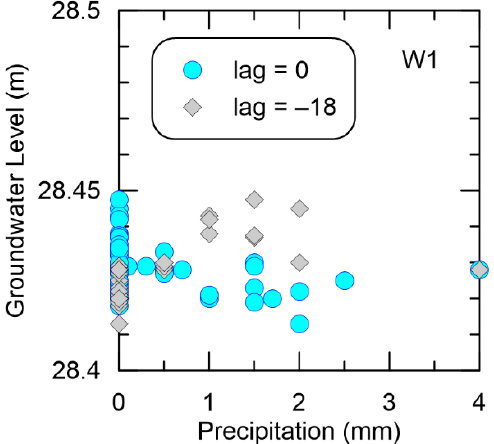
Figure 16. Example plot of groundwater levels at W1 against precipitation at one-hour intervals for a window spanning one day before and after the earthquake, indicating a negative correlation. Data for lag = 0 and –18 is shown.